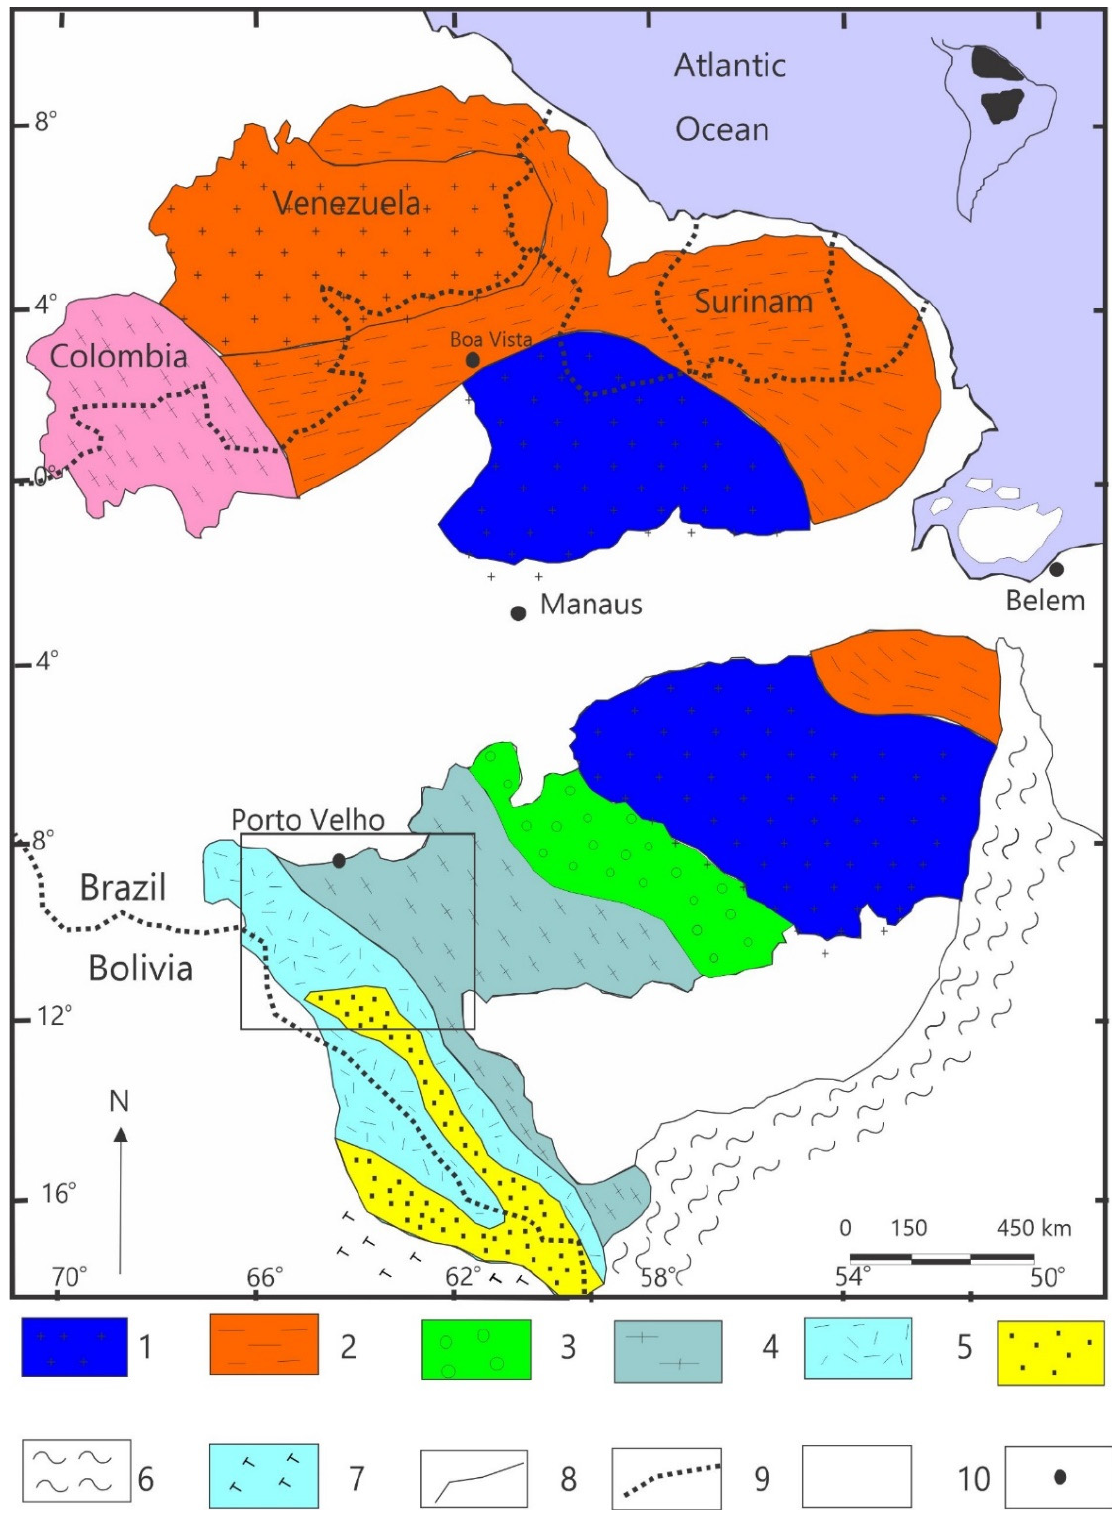
Figure 1. Subdivisions of geochronological provinces of the Amazon Craton, black rectangle indicates the location of the Rondônia Tin Province. Source: Modified from [31] with updated geochronological data according to [39–41].